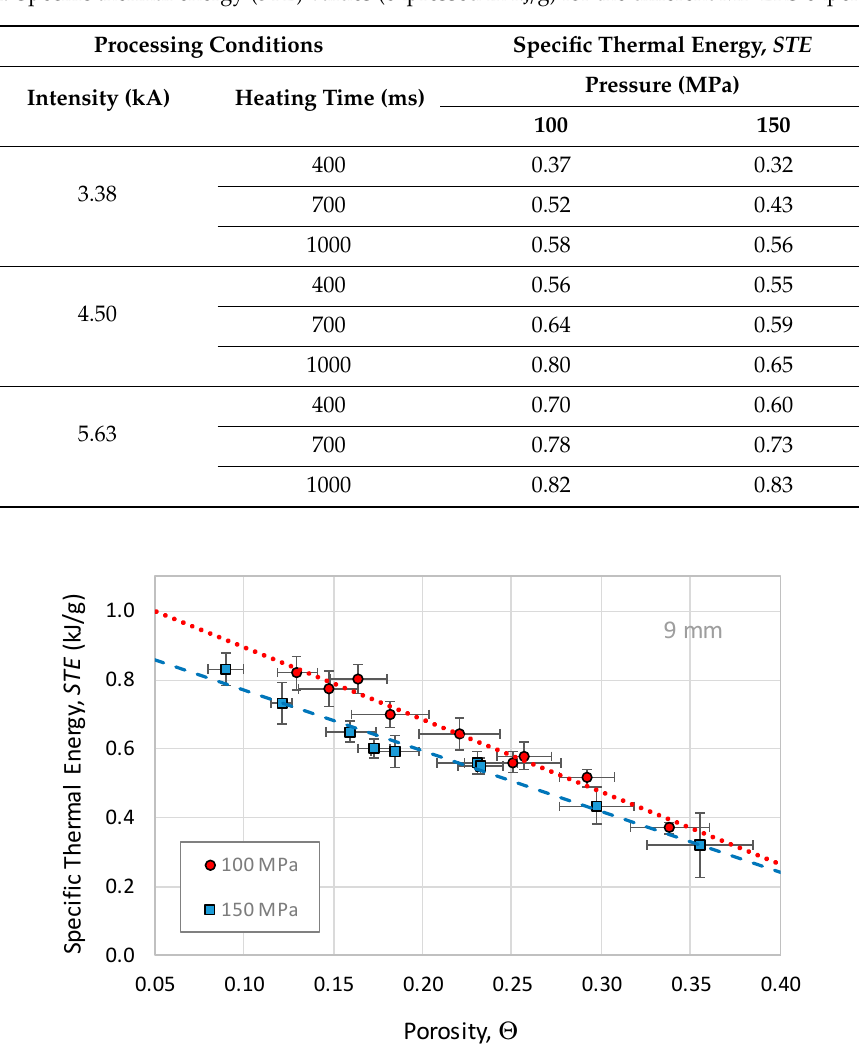
Table 2. Specific thermal energy ( STE) values (expressed in kJ/g) for the different MF-ERS experiments. Processing Conditions Specific Thermal Energy, STE Intensity